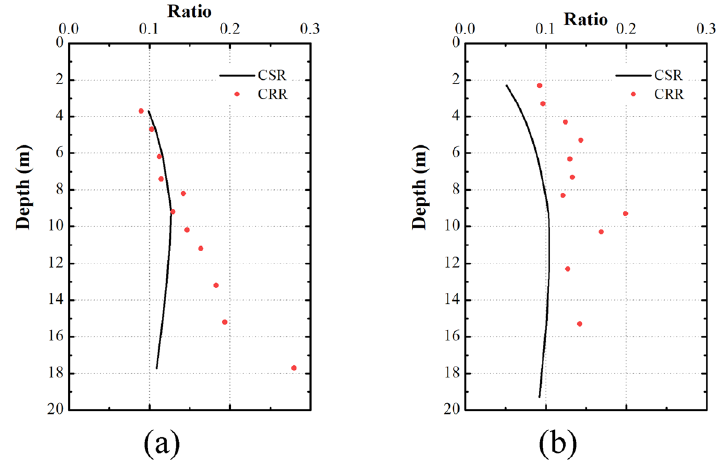
Figure 11. Seed-Idriss method’s point at ( a ) liquefaction and ( b ) non-liquefaction site.